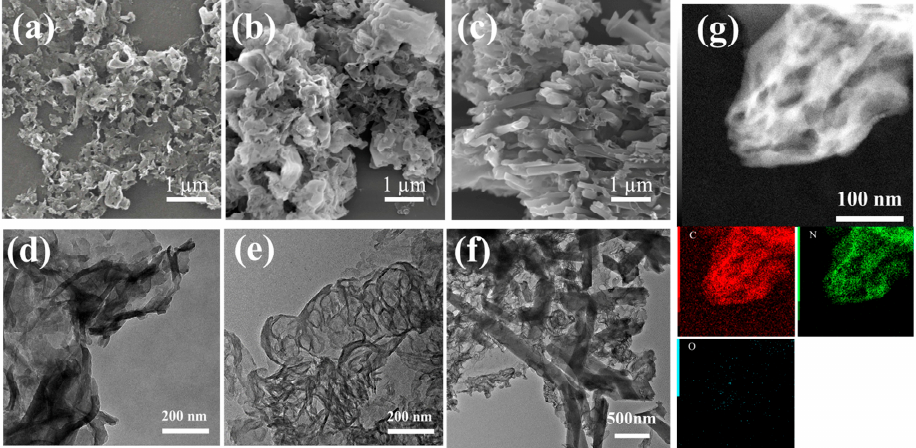
Figure 1. SEM images of the g-CN ( a ), g-CN-1 mg PTCDA ( b ), and g-CN-1g PTCDA ( c ). TEM images of the g-CN ( d ), g-CN-1 mg PTCDA ( e ), and g-CN-1g PTCDA ( f ) and the corresponding